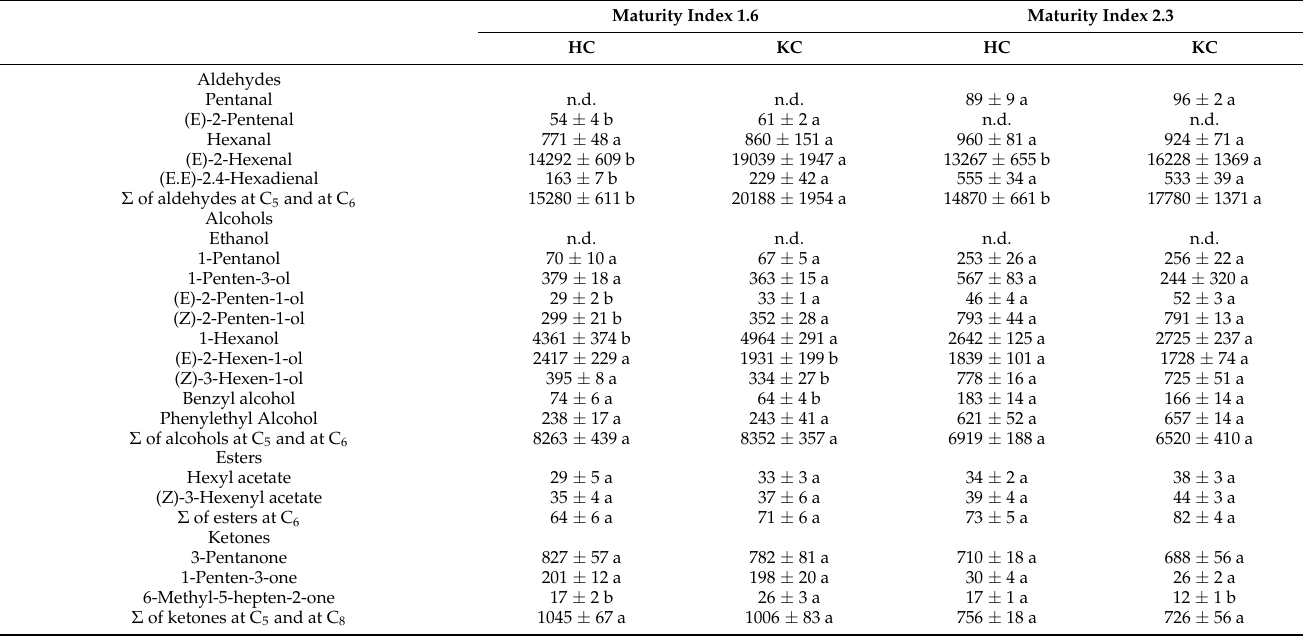
Table 7. Volatile compounds detected in olive oils. Data expressed as µ g kg − 1